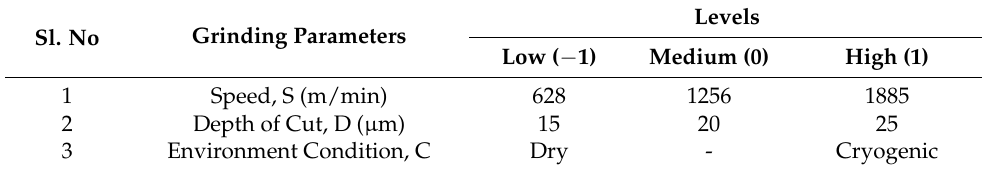
Table A1. Grinding parameters and levels. Sl. No